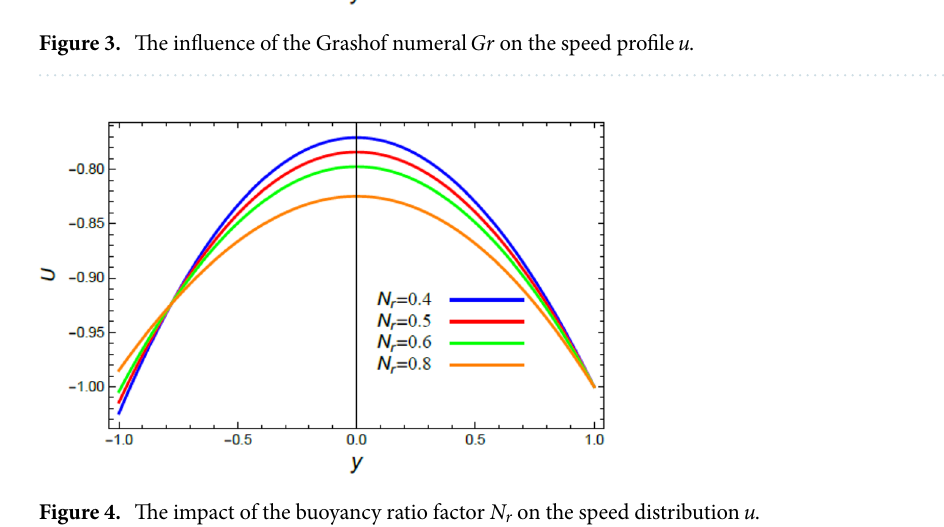
Figure 4. The impact of the buoyancy ratio factor N r on the speed distribution u .